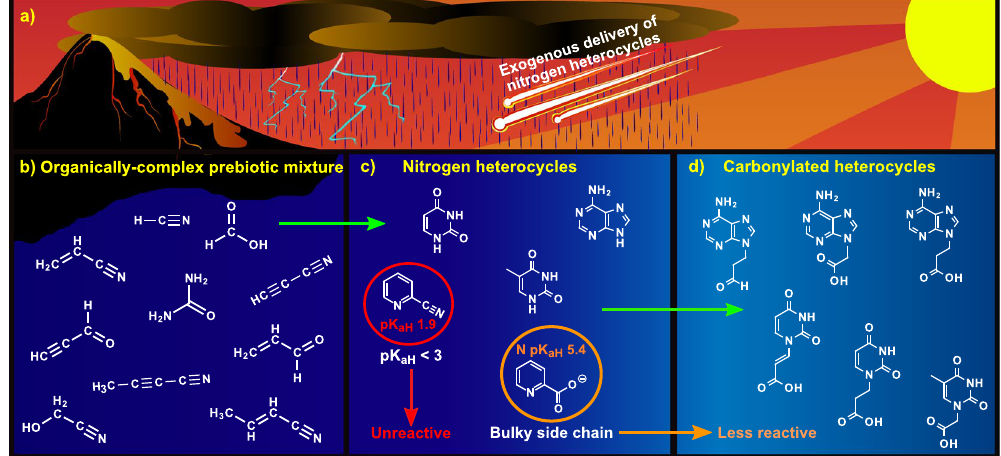
Figure 5. The chemical evolution of N-heterocycles into plausible pre-RNA monomers in aqueous solutions on early Earth. ( a ) N-heterocycles may have been delivered to the early Earth by meteorites 4,19 . Alternatively, electric discharges through either a reducing or neutral atmosphere produce ( b ) a complex mixture of organics that can combine to form ( c ) N-heterocycles 2,3,17,46 . Strongly acidic N-heterocycles (as indicated by low pK aH ), such as those with cyano and amide groups conjugated to the ring, deactivate the N-heterocycle for electrophilic attack. Similarly, bulky side chains such as carboxylates also decrease the nucleophilicity of the ring nitrogen, and thus the heterocycle’s reactivity in complex mixtures. ( d ) Organics formed in electric discharges readily react with a wide range of N-heterocycles to form adducts with a carbonyl side chain, which can serve as precursors for PNA